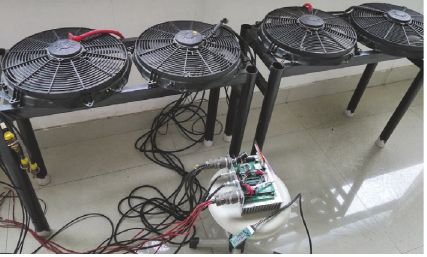
Figure 9: In lab bench test of the ECU control